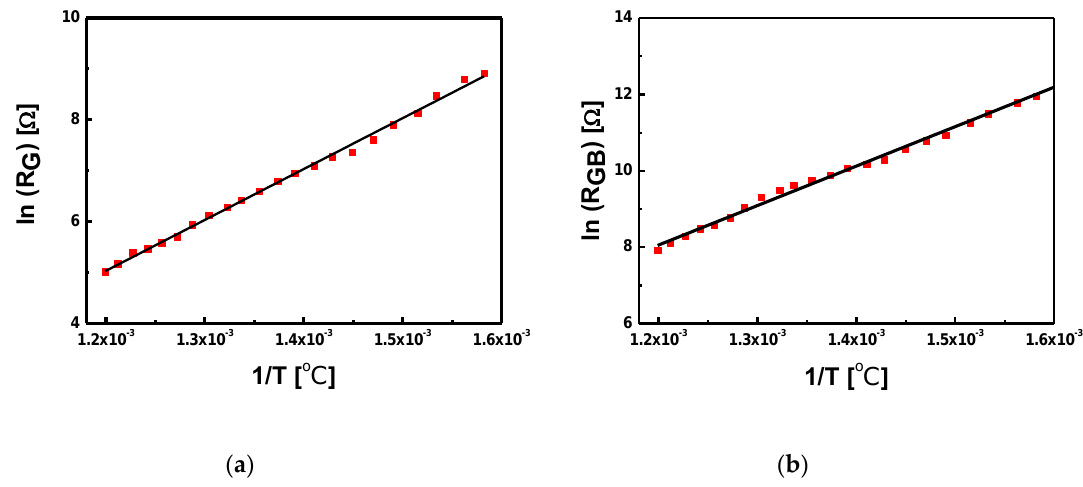
Figure 11. Dependence of the natural logarithm of the grain ( a ) and grain boundary ( b ) values calculated on the basis of impedance spectra as a function of temperature inverse of BLT4 ceramics.